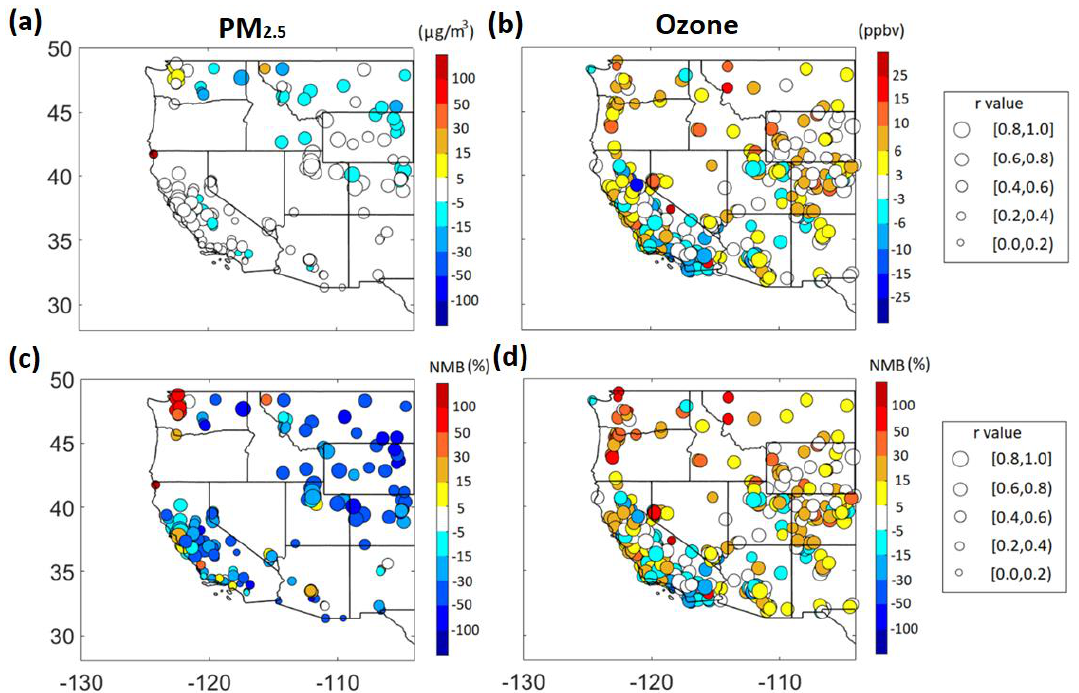
Figure 3. Spatial plot of model performance against AQS measurements during September 2017 for ( a ) surface PM 2.5 concentration and ( b ) surface ozone mixing ratios. The color scale represents mean bias (MB) values (in µg/m 3 for PM 2.5 and ppbv for ozone) and the size of the circle represents the correlation coefficient (r) value. Additionally shown are NMB (%) values (on colorscale) for PM 2.5 in ( c ) and for ozone in ( d ).